Question: Summarize what this figure shows in one sentence.
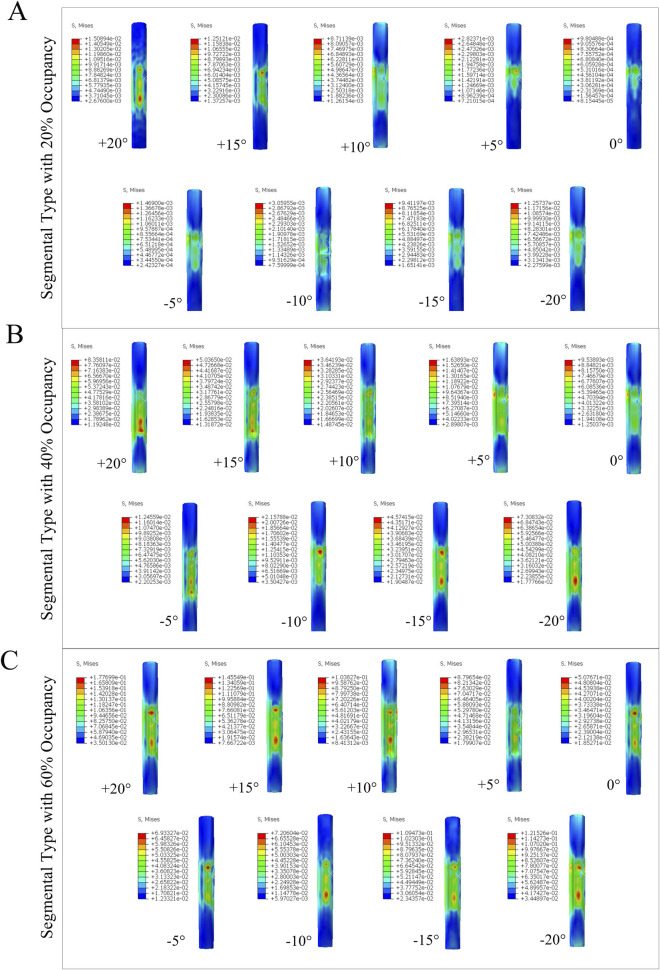
Answer: Von Mises stress distribution contours in the spinal cord gray and white matter under different spinal canal occupancy rates and flexion-extension angles for continuous C-OPLL. (A) Occupancy rate 20%; (B) Occupancy rate 40%; (C) Occupancy rate 60%. Angles in sequence: extension 20°, 15°, 10°, 5°, neutral 0°, flexion 5°, 10°, 15°, 20°. Stress scale unit: MPa.